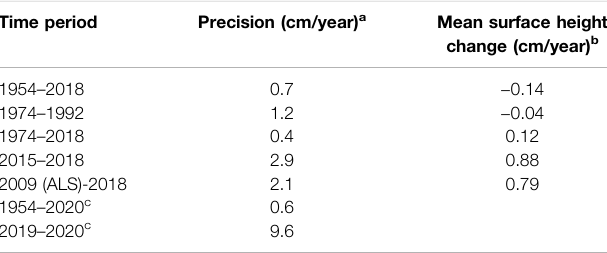
TABLE 6 | Statistical assessment of the photogrammetrically derived surface height changes. Time